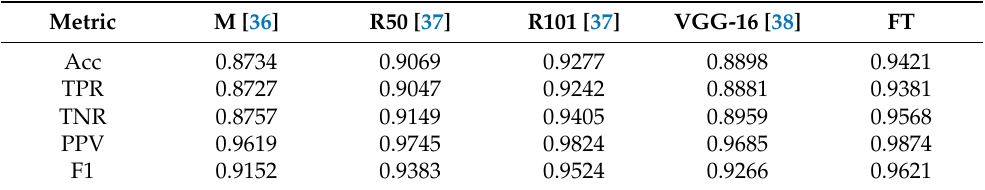
Table 8. Performance comparison on the Duke-III dataset. The proposed framework with ResNet101 [37] achieved comparable performance to the fine-tuned model.